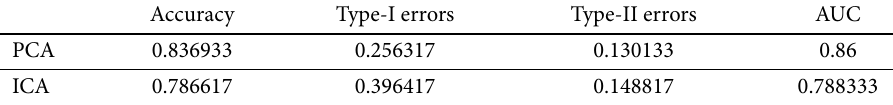
Table 4. Comparison of classification results using the PCA and ICA datasets